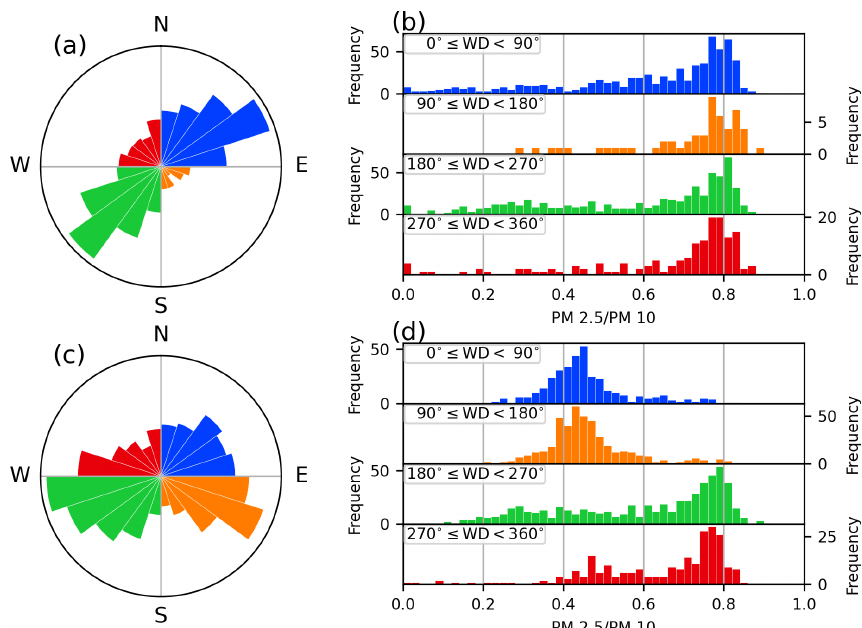
Figure 11. A comparison of R derived from hourly mean measurements by two ODIN sites under different wind directions. (a) An angular histogram of hourly wind mean direction measured by the Kyle Street AWS; the colours indicate the quadrants used in panel (b) . The “bars” are scaled for area rather than length. (b) Histograms of the R derived from measurements made with ODIN 172. The data are split into four histograms based on the wind direction in panel (a) . Panels (c) and (d) are as for (a) and (b) but instead using the New Brighton Pier AWS for the wind direction and ODIN 156 for the PM values used to calculate R